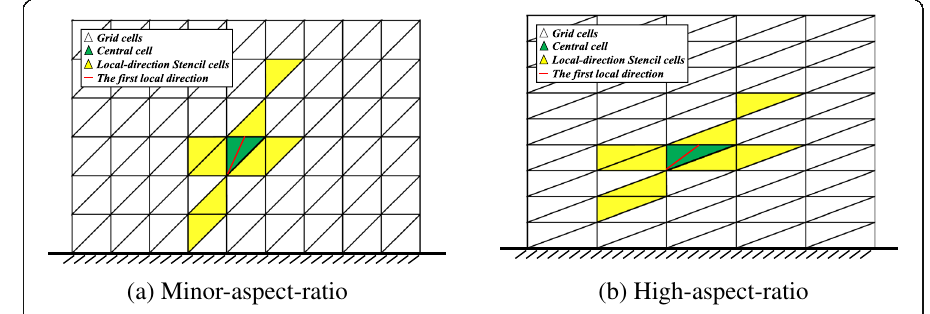
Fig. 4 Local-direction stencil cells on ( a ) minor and ( b ) high-aspect-ratio triangular